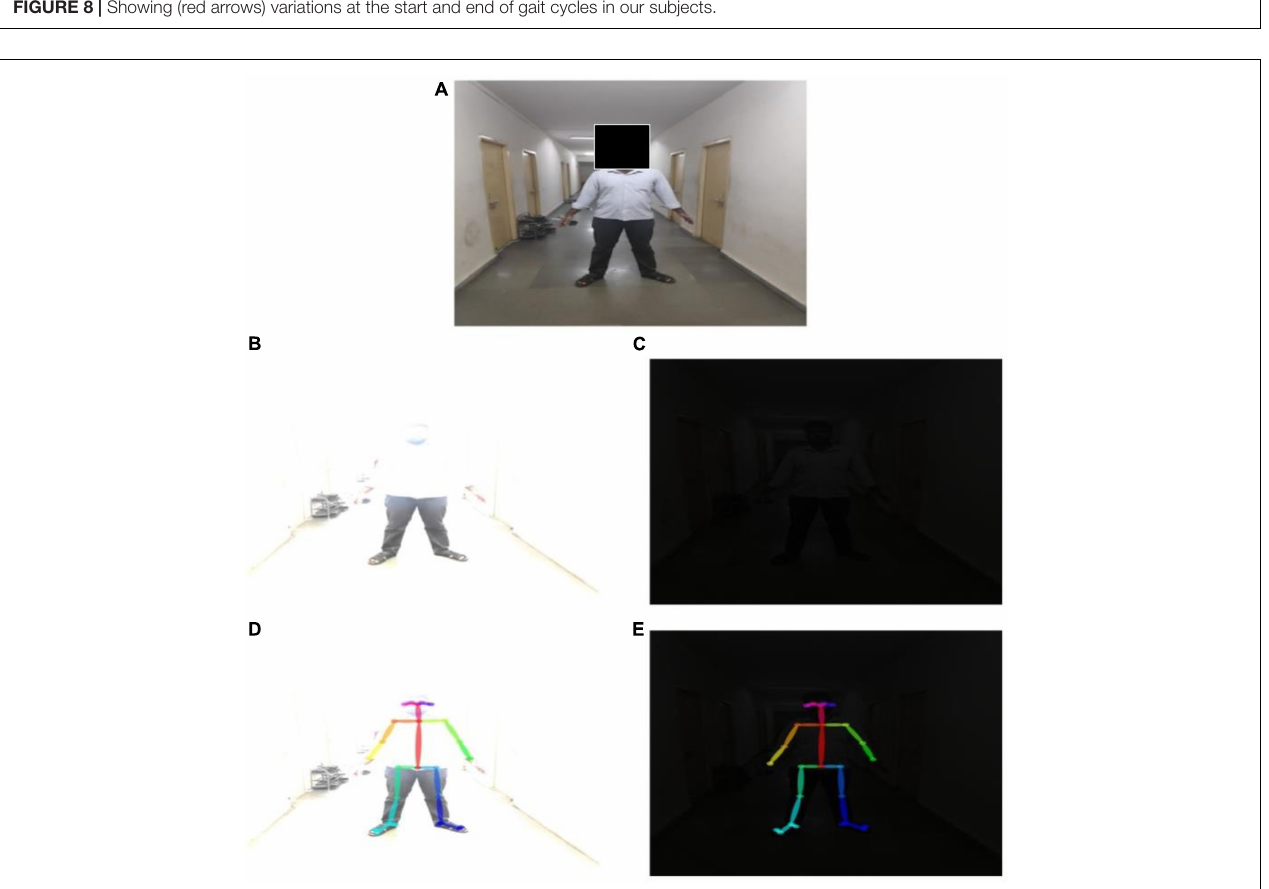
FIGURE 9 | Body pose estimation for extreme lighting conditions. (A) Original image. (B) Whitewashed image. (C) Darkened image. (D) BODY_25 pose estimation for whitewashed image. (E) BODY_25 pose estimation for darkened image.